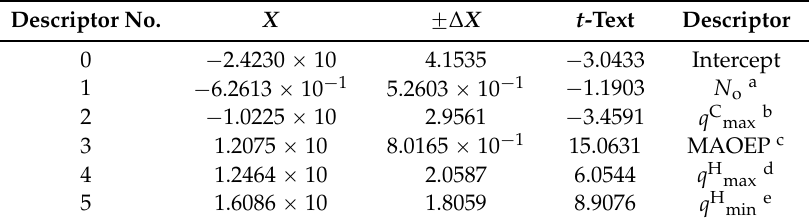
Figure 4. Optimized structures and HOMO energy maps for compounds 5c , f from the DFT calculations of Gaussian 03W. The green parts represent positive molecular orbitals, and the red parts represent negative molecular orbitals. Table 3. The best five-descriptor model.